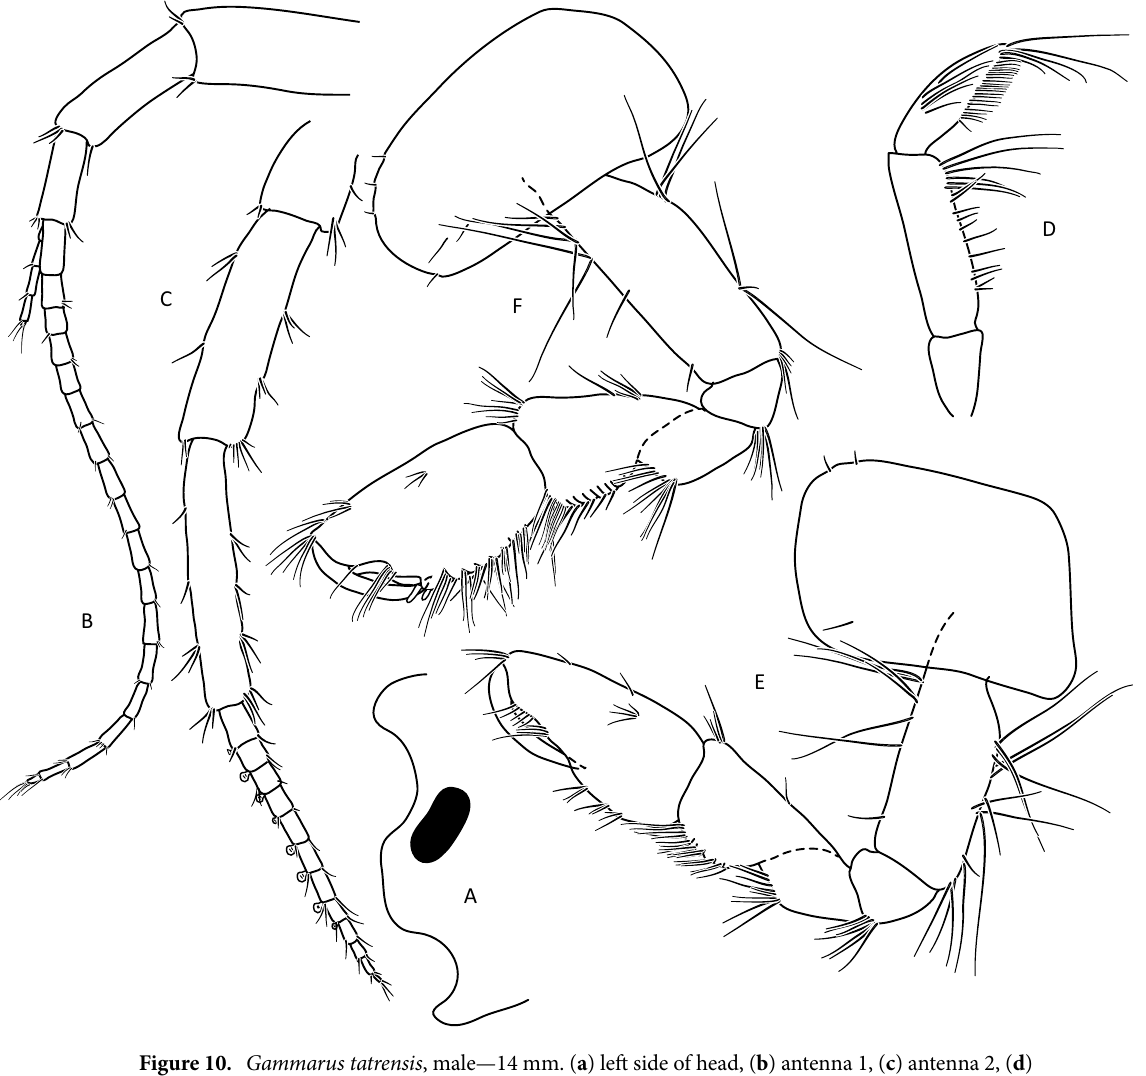
Figure 10. Gammarus tatrensis , male—14 mm. ( a ) left side of head, ( b ) antenna 1, ( c ) antenna 2, ( d ) mandibular palp, ( e ) gnathopod 1, ( f ) gnathopod